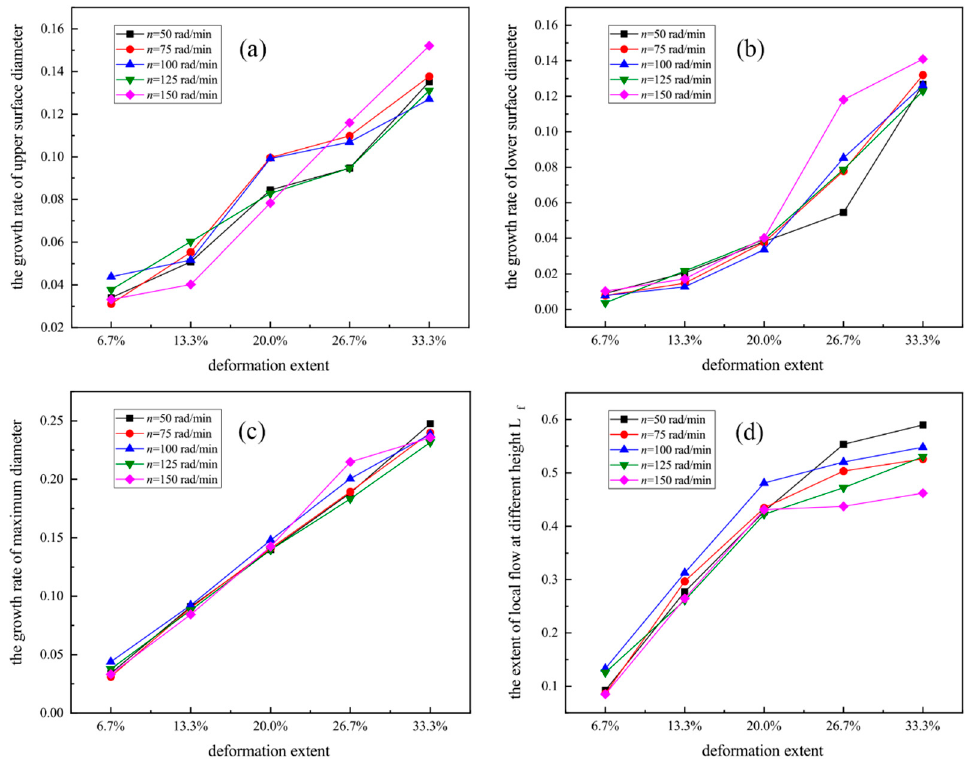
Figure 8. Influence of rotational speed n of the upper dies on metal flow during the hot double-roll rotary forging process. ( a ) The growth rate of upper surface diameter. ( b ) The growth rate of lower surface diameter. ( c ) The growth rate of maximum diameter. ( d ) The extent of local flow at different heights L f .